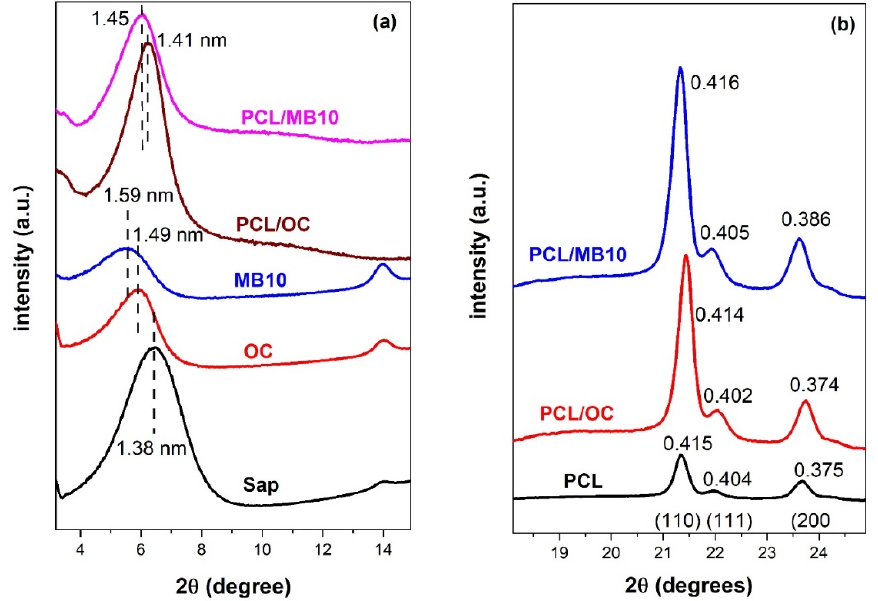
Figure 2. X-ray diffraction patterns of ( a ) the films of Saponite (Sap), organoclay (OC), organoclay with MB (MB10) deposited on PTFE filter membranes, and related composites PCL/OC and PCL/MB10. ( b ) Details on the pattern at longer angles showing the reflections due to the polymer phase (110), (111), and (200). The numbers labeling the reflection peaks show d values (nm). PCL is a semicrystalline material and its crystalline phase can be detected in the range of 15° − 30° (2 θ ) [19]. Three reflections at 21.4°, 22°, and 23.7° (Figure 2b) were attributed to